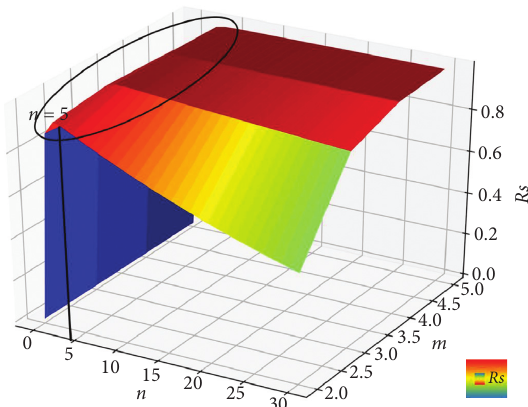
Figure 6: Reliability curve of series-parallel system as a function of parameter n